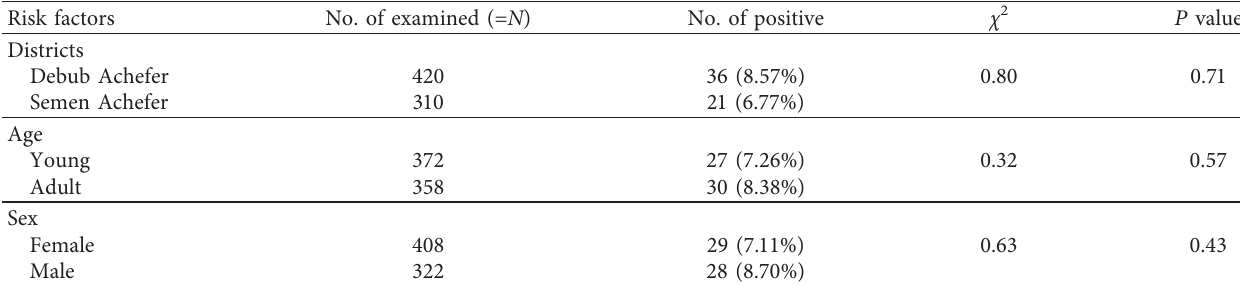
Table 1: The prevalence of trypanosomosis and associated risk factors.